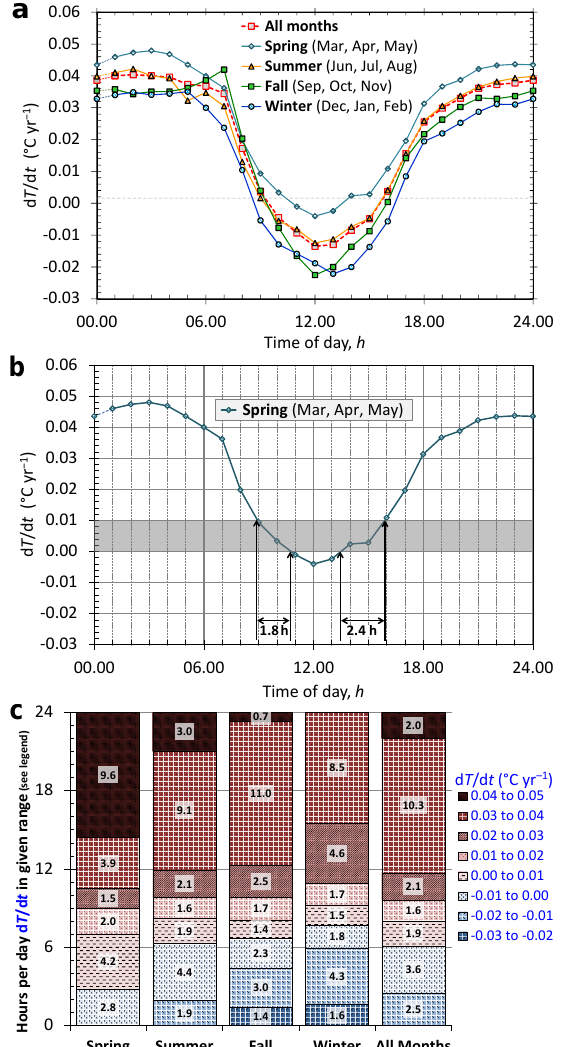
Fig. 3. Best-fit trend-line slopes, d T /d t , for the 30-yr Mauna Loa Observatory, Hawaii data (NOAA, 2009), as a func- tion of time of day, h , for each season and all months to- gether: (a) Annual mean rates of warming (cooling) d T /d t for 1977–2006 are given for “all months” (large squares, same as Fig. 2b), and the four seasons: spring (diamonds; March, April, May), summer (triangles; June, July, August), fall (small squares; September, October, November), winter (circles; De- cember, January, February). The mean rates of warming for the four seasons are: d T /d t =0.027 ± 0.019 ◦ Cyr − 1 (spring),